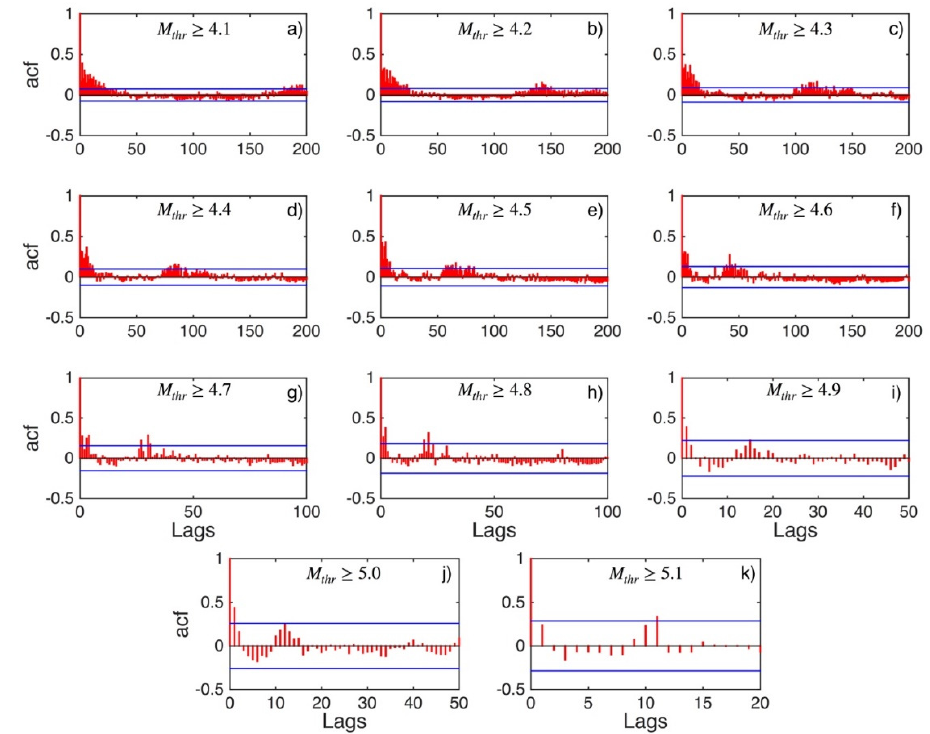
Figure A1. ACF values (red stems) and their 95% confidence intervals (blue lines) for Western Greece and Albania (sub-area 1) for magnitude thresholds ( M thr ) varying from 4.1 to 5 (subplots a – k ).